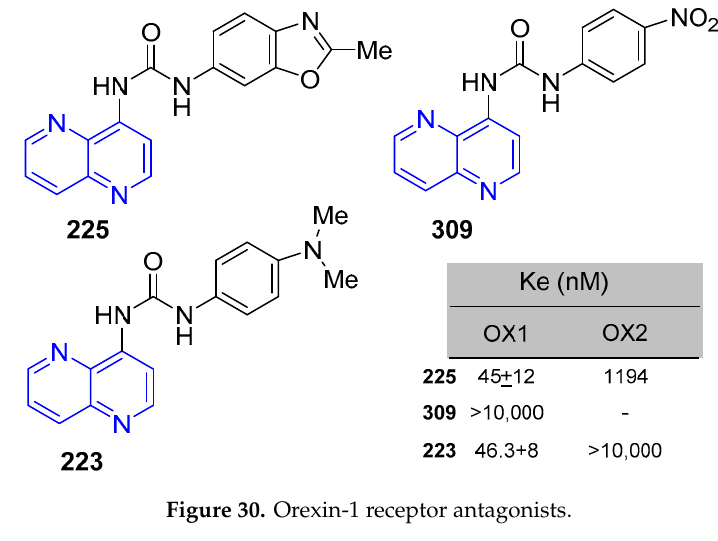
Figure 30. Orexin-1 receptor antagonists.